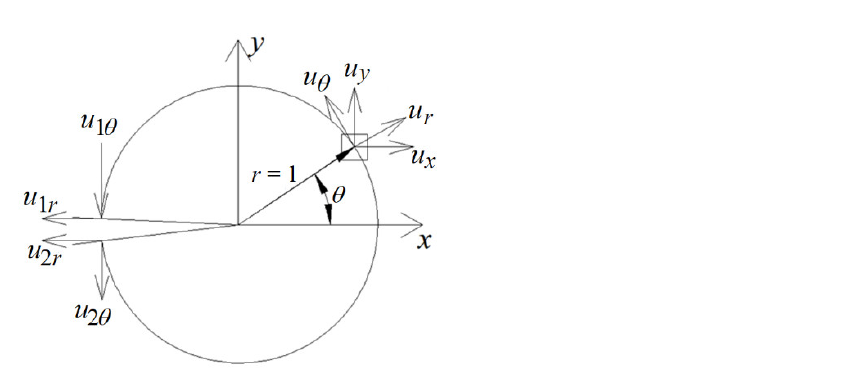
Figure 9. Diagram of determining the displacements on both sides of the crack.